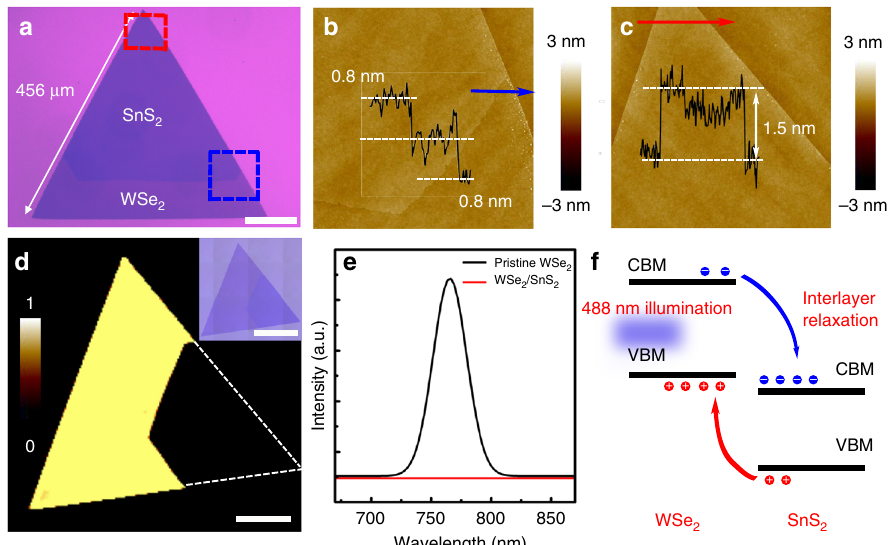
Fig. 3 AFM and PL characterization of the vertically stacked WSe 2 /SnS 2 heterostructure. a Optical micrograph of a large-scale 1 L SnS 2 /1 L WSe 2 stacked triangular fl ake grown on SiO 2 /Si. Scale bar, 100 μ m. b AFM image of the blue rectangle region in a . Inset is height pro fi le along blue arrow, indicating the thickness of bottom layer and top layer is 0.8 and 0.8 nm, respectively. Corresponding to 1 L SnS 2 on 1 L WSe 2 . c AFM image of the red rectangle region in a . Inset is the height pro fi le across the red arrow, indicating the thickness of the heterostructure is 1.5 nm (1 L WSe 2 + 1 L SnS 2 ). d PL intensity mapping (720 – 780 nm). Scale bar, 60 μ m. Inset image is the optical image of the sample used for PL characterization. Scale bar, 100 μ m. e PL spectra observed from bare WSe 2 region (black curve) and WSe 2 /SnS 2 vdW heterostructure region (red curve). f Schematic diagram of WSe 2 /SnS 2 heterostructure band structure and photoexcitation, interlayer relaxation process in WSe 2 /SnS 2 (red, point 2 in Fig. 2b) regions, respectively. Except the Cu signal from the grid, only elements W and Se were collected from the monolayer region, while apart from W and Se, elements Sn and S were also detected at the bilayer region, indicating the formation of WSe 2 /SnS 2 heterostructure, which can also be well demon- strated by the element line scans across the interface region (Fig. 2d). The high resolution transmission electron microscope (HRTEM) image and the selected electron diffraction pattern (SAED) (Fig. 2e) show the bottom region is well crystallized with the measured lattice spacing of 0.28 nm, well consistent with the value of (100) plane spacing of WSe 2 . The bilayer heterostructure region shows obvious Moiré patterns (Fig. 2f), caused by the overlapping lattices between SnS 2 and WSe 2 . The smallest periodic repeated cell is demarcated by the red dashed rhombus, with a lattice constant of 2.24 nm. The corresponding SAED shows two different sets of hexagonally arranged diffraction patterns (Fig. 2g), with the calculated lattice spacings consistent with the SnS 2 (0.32 nm) and WSe 2 (0.28 nm), respectively 44 . The large lattice mis fi t (14.3%) indicates that the SnS 2 domain is – 42 . Figure 2h stacked on the WSe 2 through vdW epitaxy 36, 37, 40 and i gives the top and side views of the theoretical atomic structure model of the WSe 2 /SnS 2 heterostructure with Moiré patterns, consistent with the experimental observation shown in Fig. 2f, with the periodic repeated cell marked by the red dashed rhombus, corresponding to 7 × 7 SnS 2 stacked on 8 × 8 WSe 2 41 . The thickness of the as-grown heterostructures was further con fi rmed by atomic force microscope (AFM) measurements. Figure 3b and c is the AFM images detected at the selected stack region (red dashed rectangle) and the interface region across from SnS 2 to WSe 2 (blue dashed rectangle), respectively, as marked in Fig. 3a. The insets of the AFM images show the corresponding line scan height pro fi le, indicating that the thickness of both the bottom and the top layer are 0.8 nm, with a total thickness at the stack region of 1.5 nm, well demonstrating the achieved bilayer heterostructures (1 L WSe 2 + 1 L SnS 2 ).